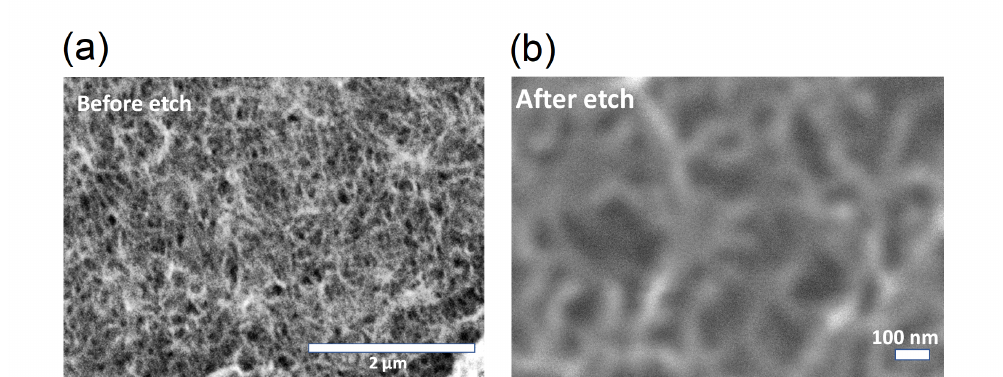
Figure 2. SEM images of MWCNT networks deposited on Si/SiO 2 substrate: ( a ) before surfactant removal. The CNTs have diameters over 60 nm and the bundles are CNT agglomerates; ( b ) after surfactant removal. The diameter of the CNTs is reduced to about 30 nm and they appear to have relatively smooth surfaces.